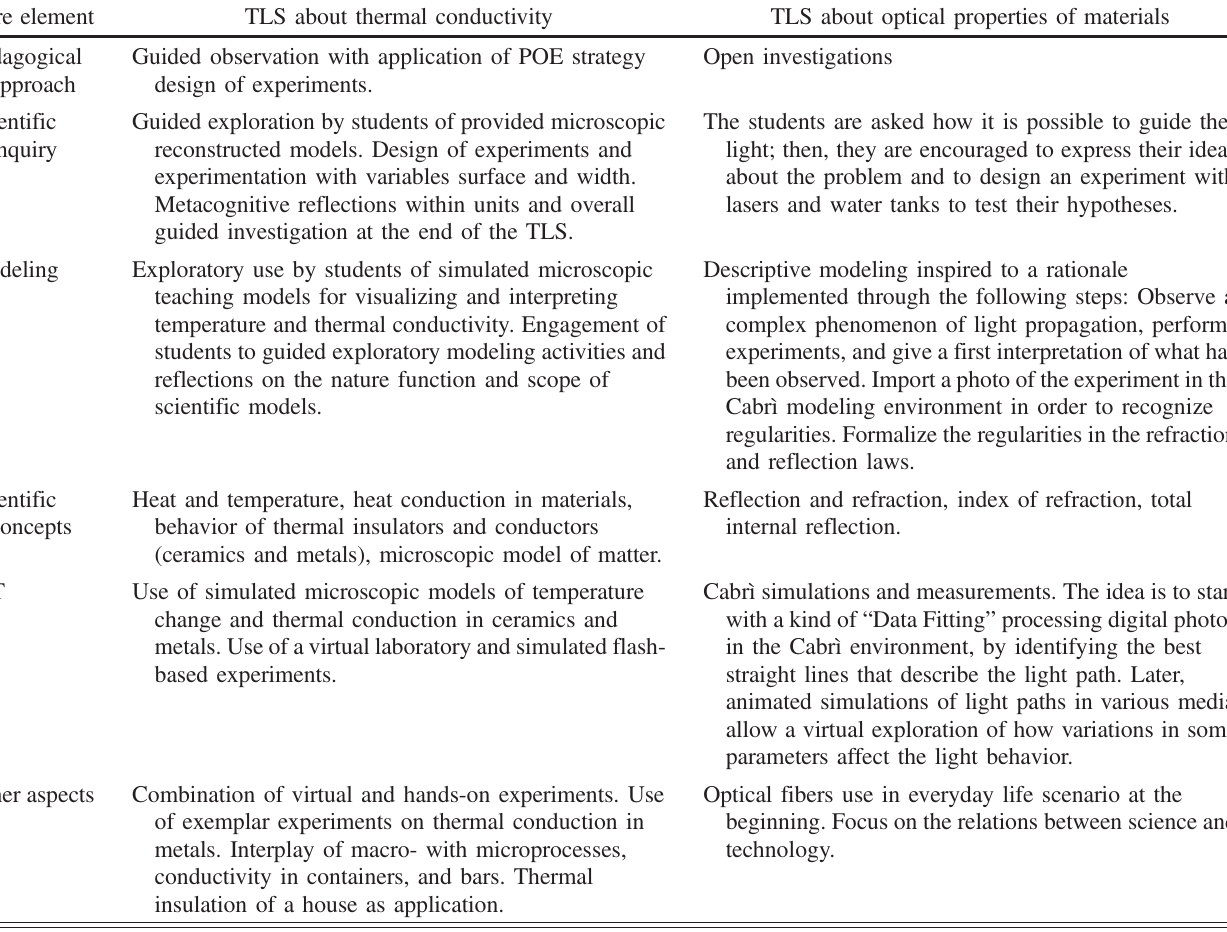
TABLE III. Core elements of the original teaching-learning